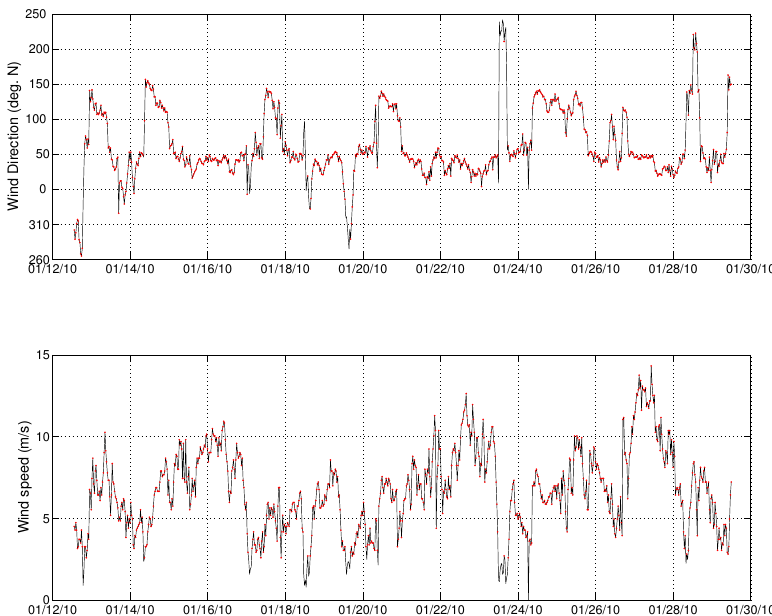
Fig. 2. Wind recorded at the RON buoy of Civitavecchia, 12–29 January 2010. Upper panel: wind direction; lower panel: wind speed. Red dots indicate wind speed greater than 2.5 m s − 1 .